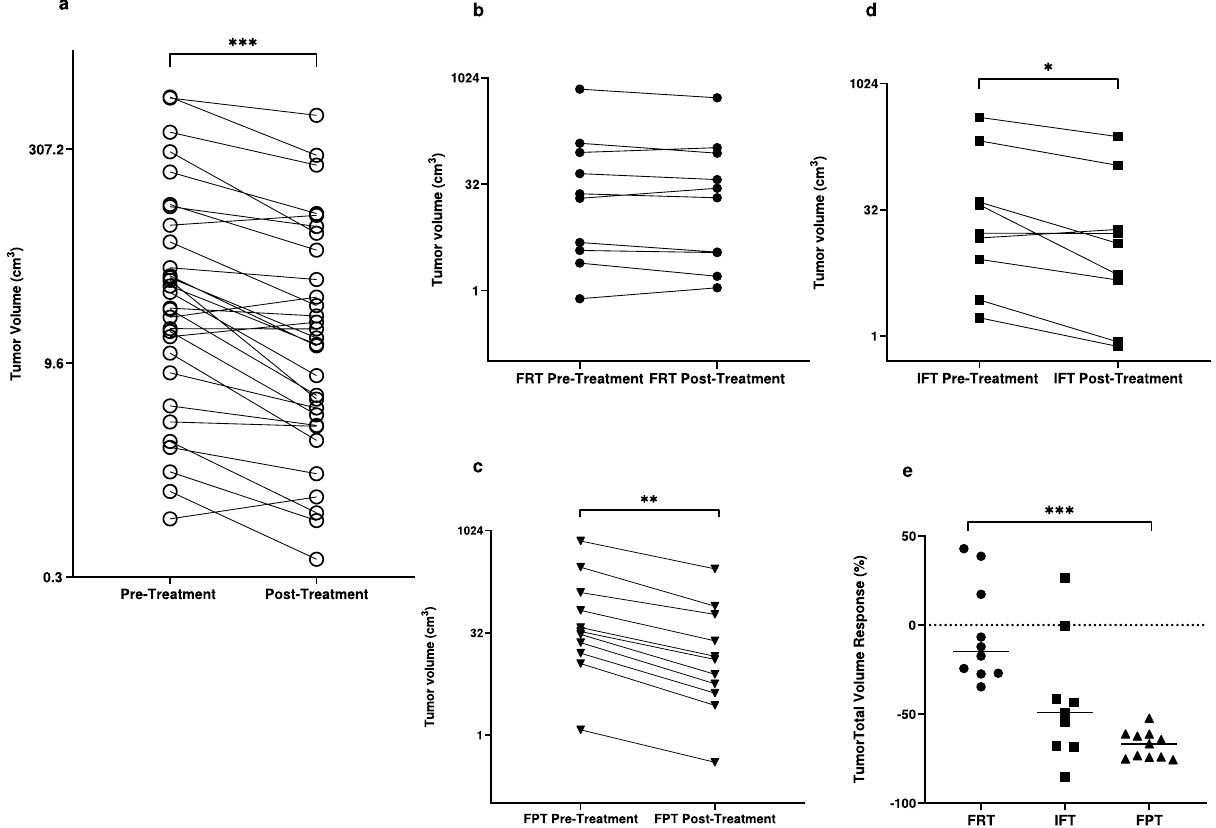
Figure 1. Total tumor volume pre- and post-treatment with sirolimus for all AMLs ( a ), fat-rich tumors ( b ), intermediate-fat tumors ( c ) and percent response to sirolimus for each tumor type ( d ). Repeated measures were analyzed using the Wilcoxon test, whereas comparisons among tumor fat profiles were performed with the Kruskal–Wallis test. AML angiomyolipoma, FPT fat-poor tumor, FRT fat-rich tumor, IFT intermediate-fat tumor. *P < 0.05, ***P <